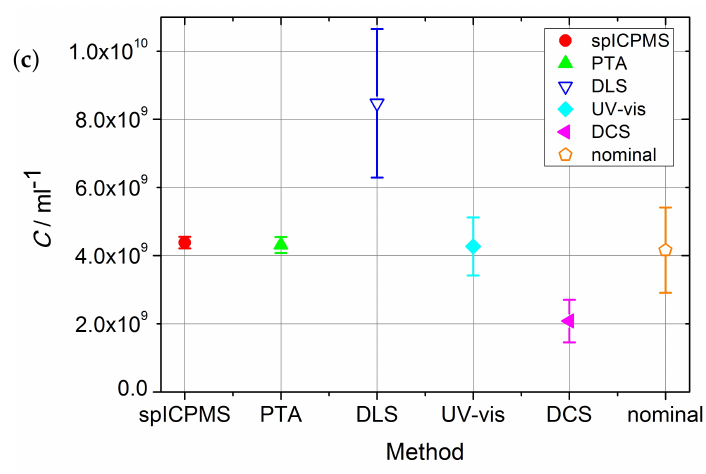
Figure 2. Comparison of number concentrations and corresponding standard uncertainties acquired with reference and laboratory methods for ( a ) Au10, ( b ) Au30 and ( c ) Au100 samples. Open symbols depict methods without full uncertainty budget.